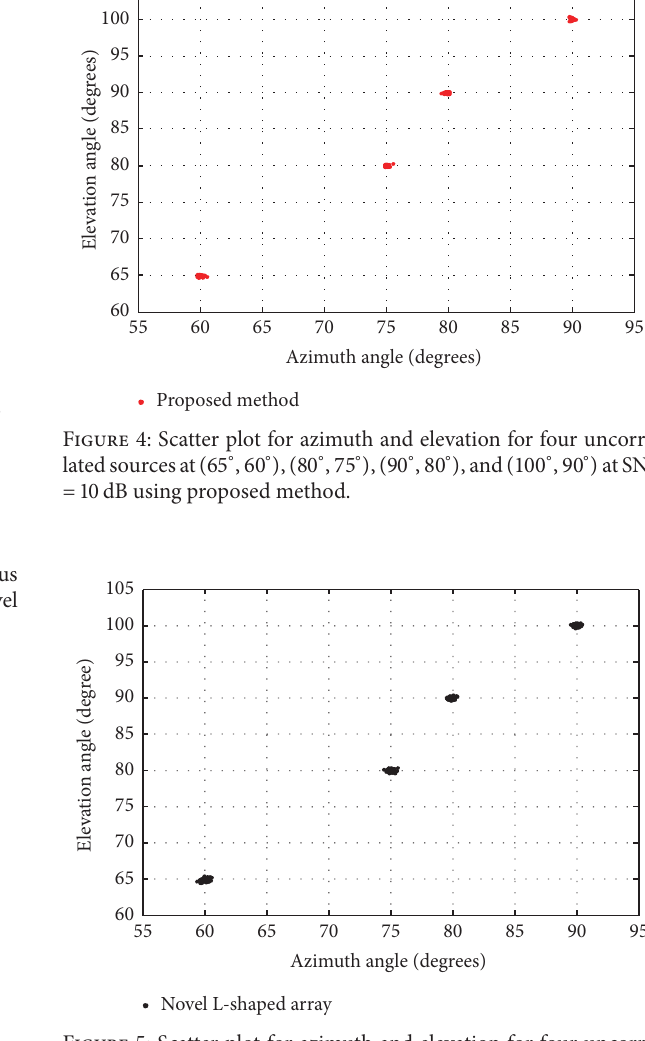
Figure 5: Scatter plot for azimuth and elevation for four uncorre- latedsourcesat (65 ∘ , 60 ∘ ) , (80 ∘ , 75 ∘ ) , (90 ∘ , 80 ∘ ) ,and( 100 ∘ ,90 ∘ ) atSNR = 10 dB using novel L-shaped method